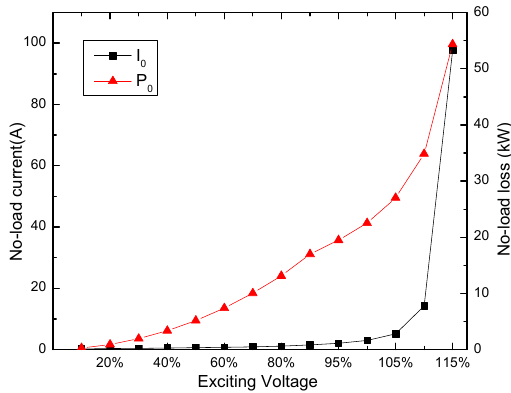
Figure 4. No-load characteristic curve of core.